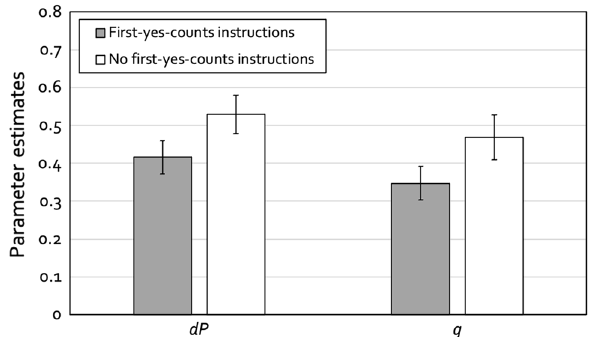
Figure 2. Estimates of parameters dP (detection of the presence of the culprit) and g (guessing-based selection) of the 2-HT eyewitness identification model as a function of lineup instructions (first-yes-counts instructions vs. no first-yes-counts instructions) for the sequential-lineup data of Horry et al. 32 . The error bars represent the standard